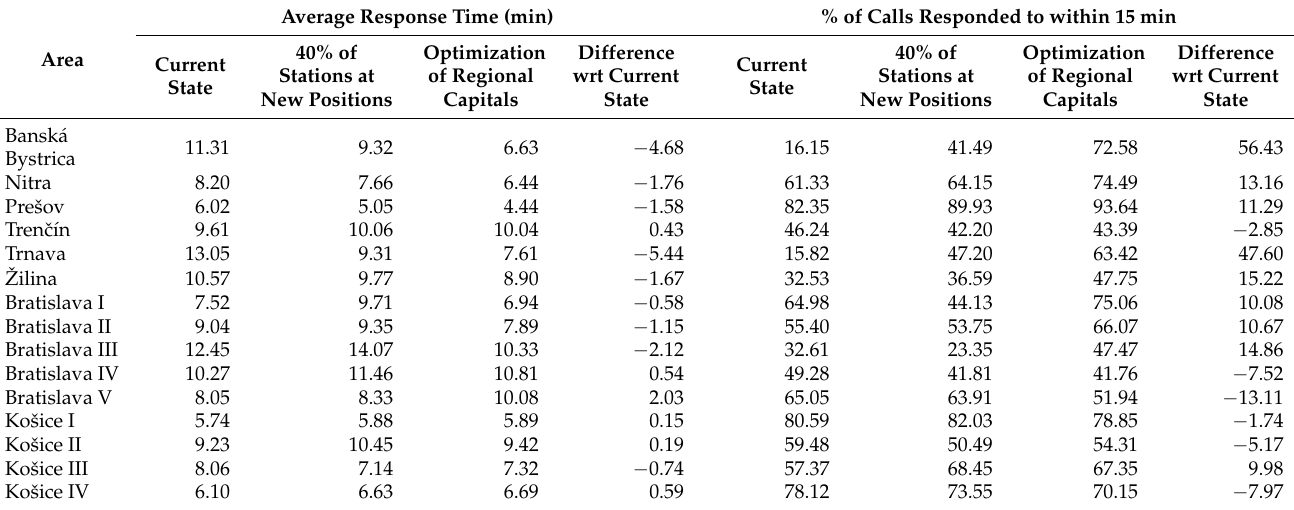
Table 7. Performance indicators with respect to FHQ